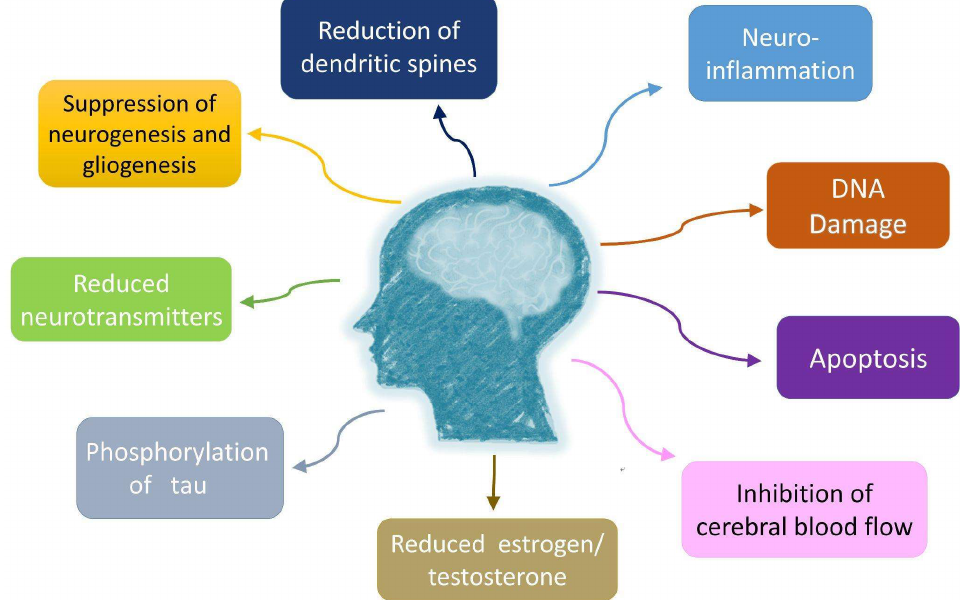
Figure 2. Several potential cellular mechanisms of cancer treatment inducing neurodegeneration have been proposed. Neuroinflammation, DNA damage, apoptosis, suppression of neurogenesis and gliogenesis, reduced neurotransmitters, phosphorylation of tau, reduced level of estrogen/ testosterone and their effects on brain, inhibition of cerebral blood flow, reduction of cortical spines, and dendrites are possible mechanisms involved.